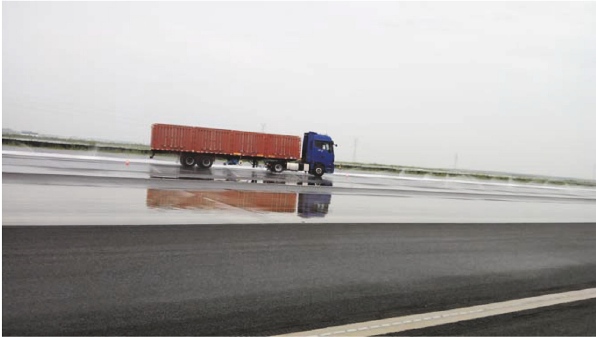
Figure 2: Image of vehicle test